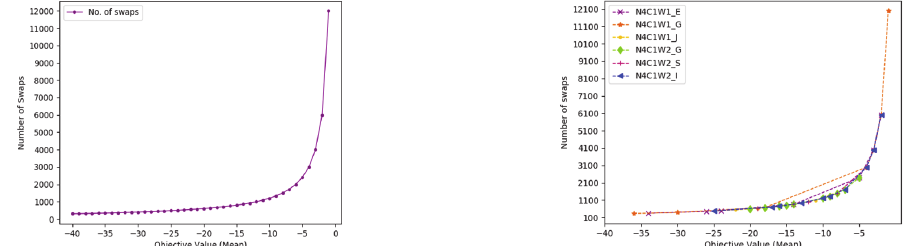
Fig. 10. Iterative local search on 6 difference instances